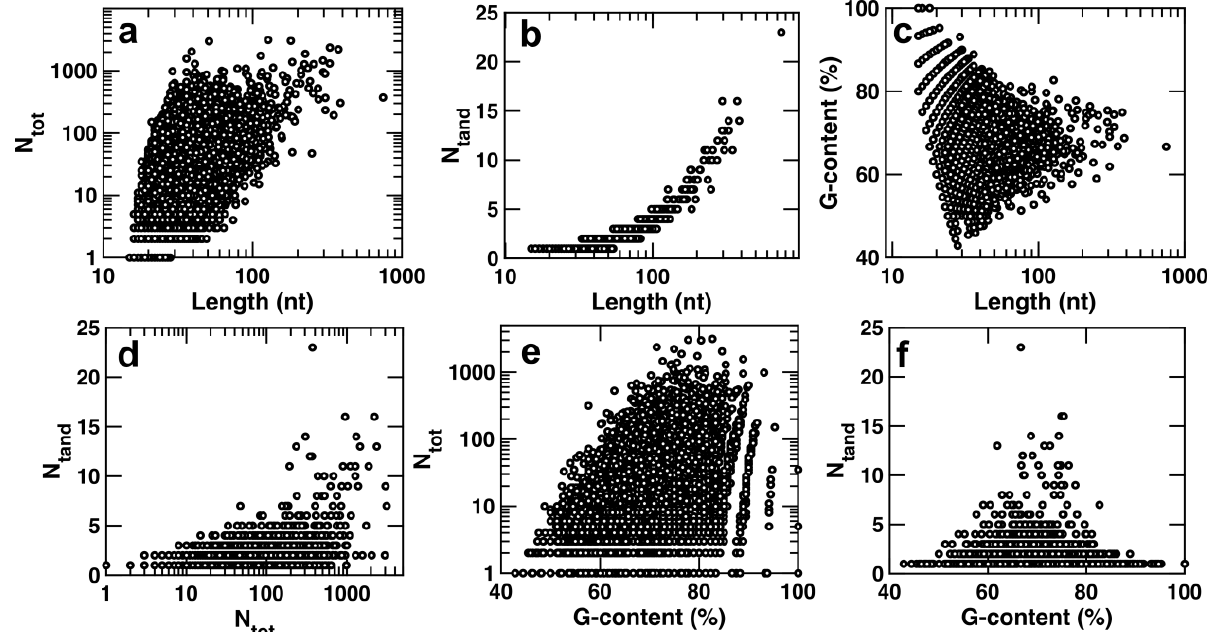
Figure 5. Scatter plots of each of the different features of G4CRs found in this study: length, percentage of residues that are G (G-content), total number of G4 isomers (N tot ), maximum number of simultaneous tandem G4s (N tand ). ( a ) N tot vs. Length. ( b ) N tand vs. Length. ( c ) G-content vs. Length. ( d ) N tand vs. N tot . ( e ) N tot vs. G-content. ( f ) N tand vs. G-content.